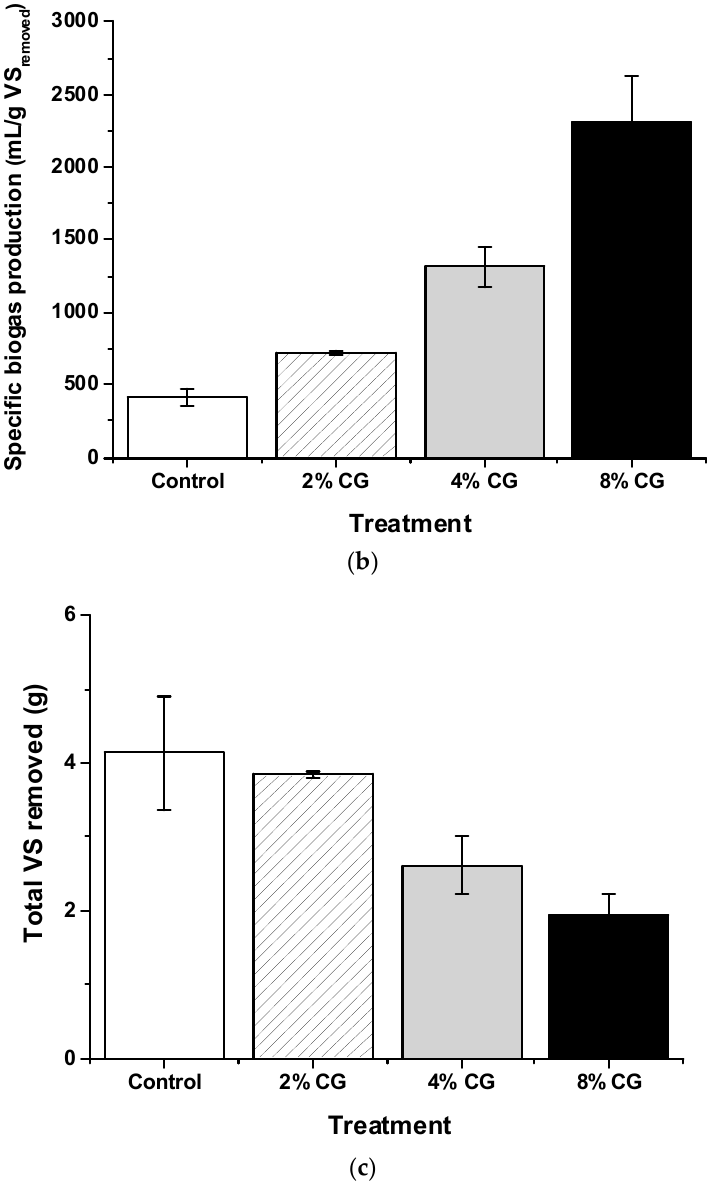
Figure 8. Changes of biogas production rates depends on VS loaded ( a ), VS removed ( b ), and total amount of VS removed ( c ) without or with different percentage of crude glycerol addition.